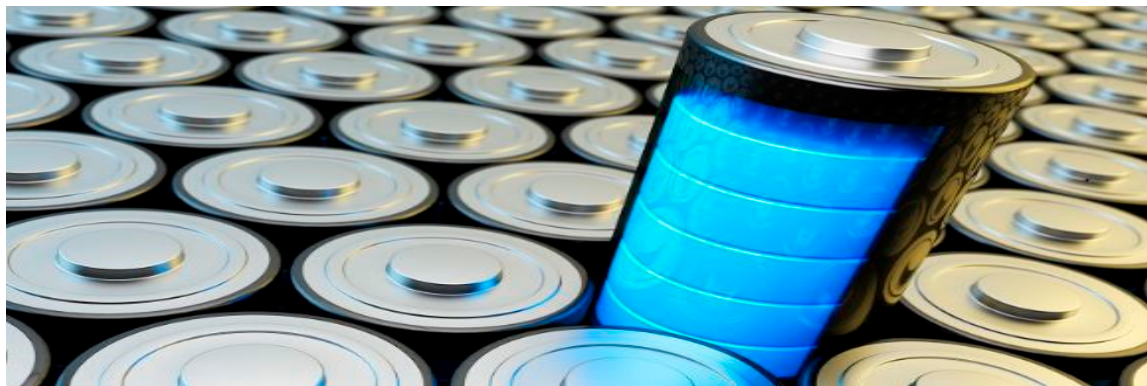
Figure 20. Non-flammable bulletproof graphene battery [16].